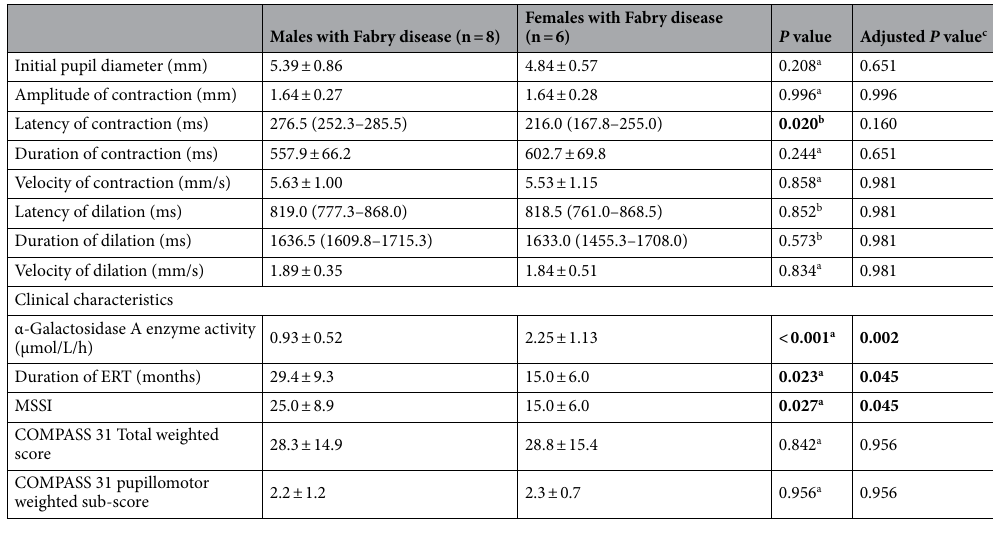
Table 3. Comparison of the study parameters among male and female subjects with Fabry disease. Data are expressed as mean ± SD for parametric variables and median (IQR) for non-parametric variables. COMPASS Composite Autonomic Symptom Scale, ERT enzyme replacement therapy, MSSI Mainz Severity Score Index. a Independent samples t-test. b Mann Whitney U-test. c P values were adjusted using a Benjamini–Hochberg false discovery rate (FDR) correction procedure. The bold P values represent statistically significant differences.